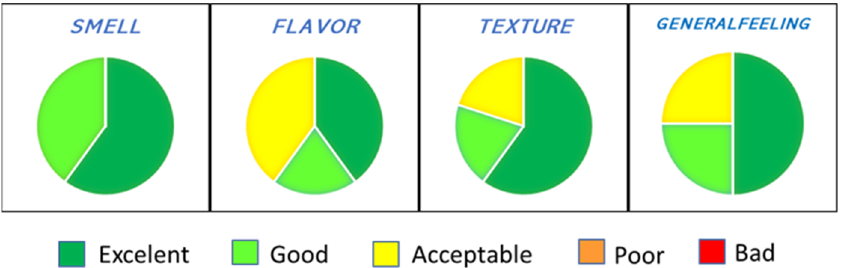
Figure 3. In vivo palatability results obtained for Lip + M + L + A, which resulted as the best- evaluated mixture.